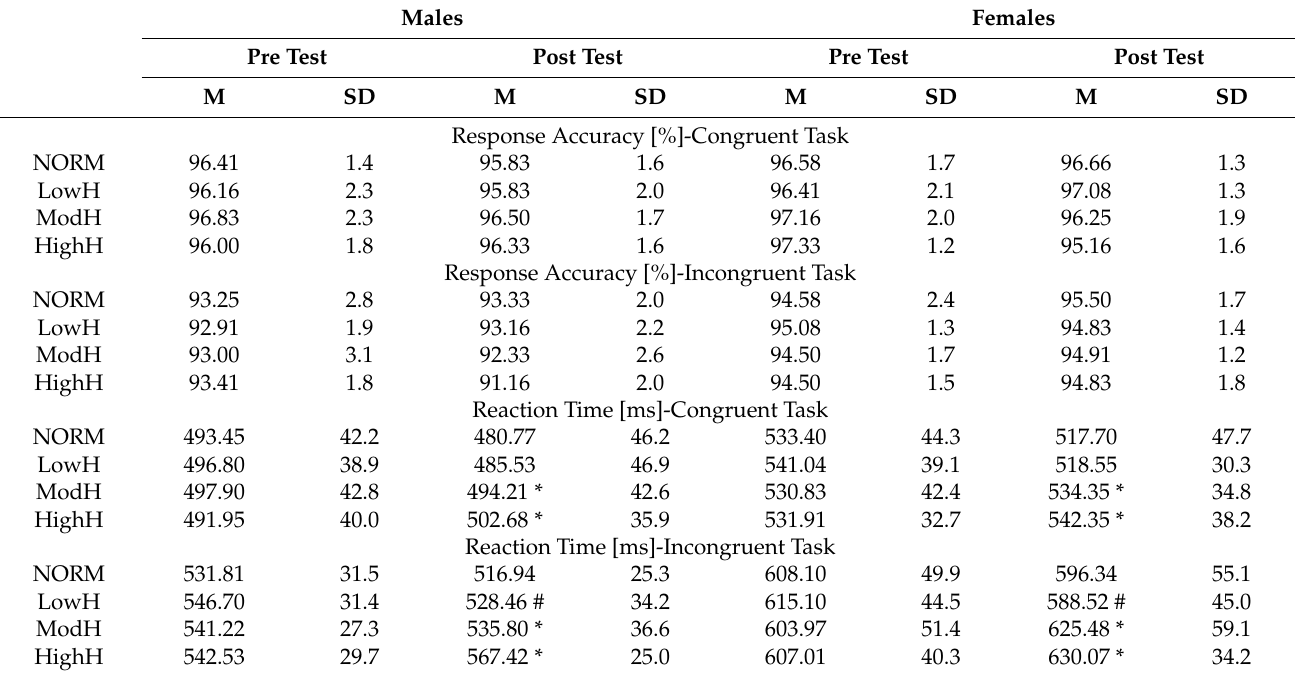
Table 1. Cognitive function